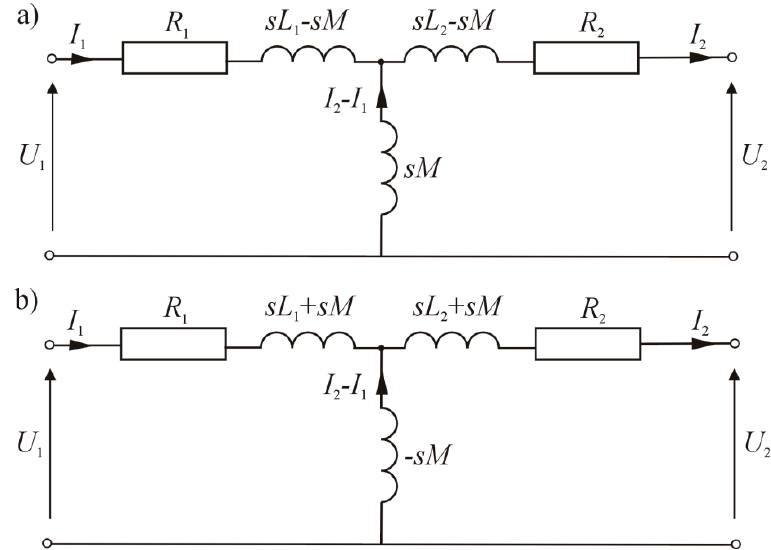
Figure 2. Operating diagrams after elimination of magnetic coupling: ( a ) opposite; ( b ) matching magnetic polarity.